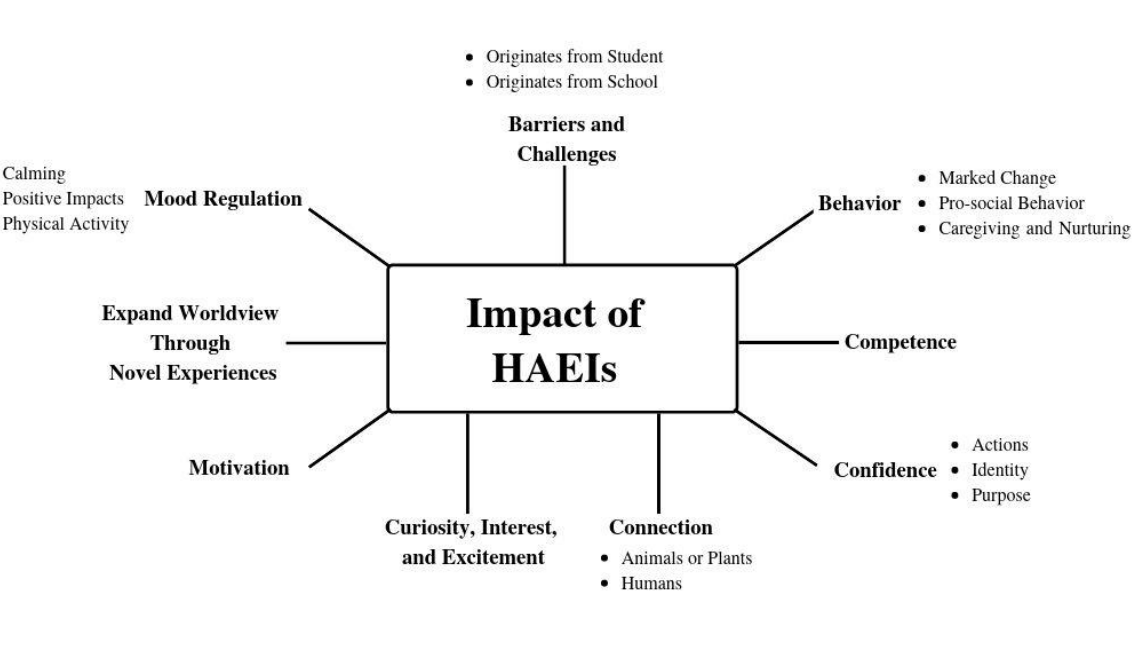
Theme: Barriers and Challenges to Implementing